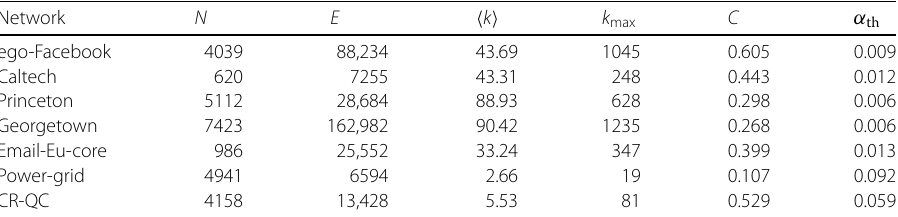
Table 3 Description of the structural properties of the real-world networks. N is the total numbers of nodes, E is the number of edges. (cid:8) k (cid:9) , k max are respectively the average and the max degree. C is the average clustering coefficient. α th is the epidemic threshold of the network Network N E (cid:8) k (cid:9) k max C α th ego-Facebook 4039 88,234 43.69 1045 0.605 0.009 Caltech 620 7255 43.31 248 0.443 0.012 Princeton 5112 28,684 88.93 628 0.298 0.006 Georgetown 7423 162,982 90.42